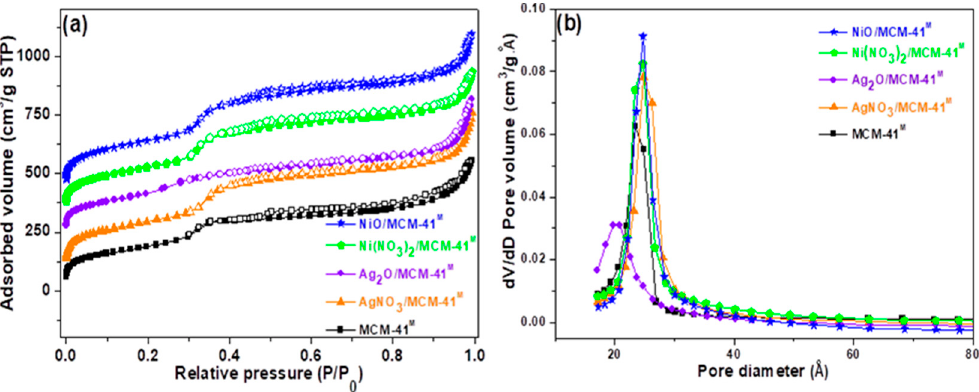
Figure 3. ( a ) N 2 adsorption-desorption isotherms at 77 K ( b ) and the corresponding BJH adsorption pore size distributions for the adsorbents.